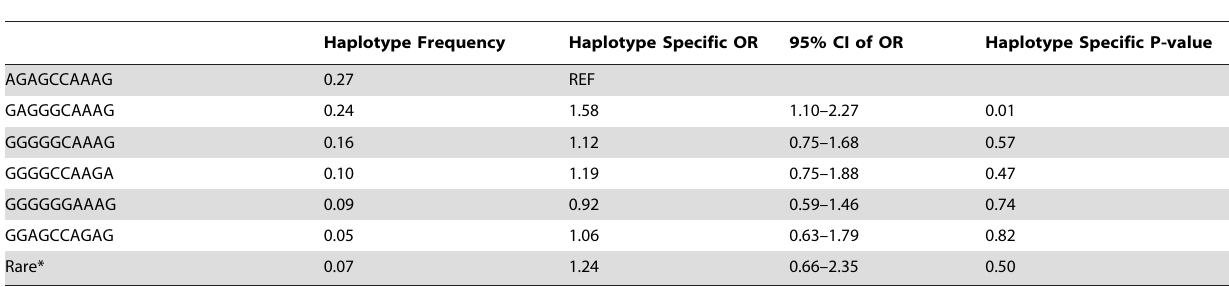
Table 3. Association results of haplotypes with asthma.